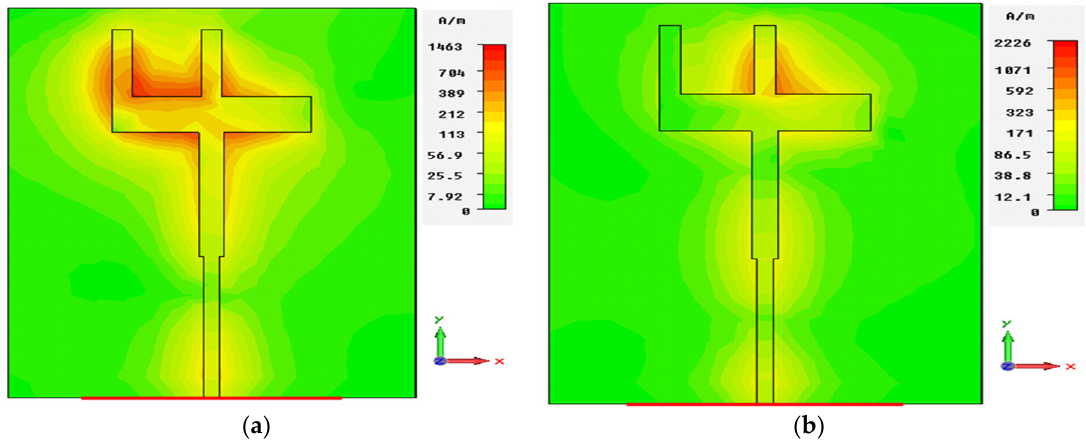
Figure 5. Surface current distribution: ( a ) at 28 GHz band and ( b ) at 38 GHz band.